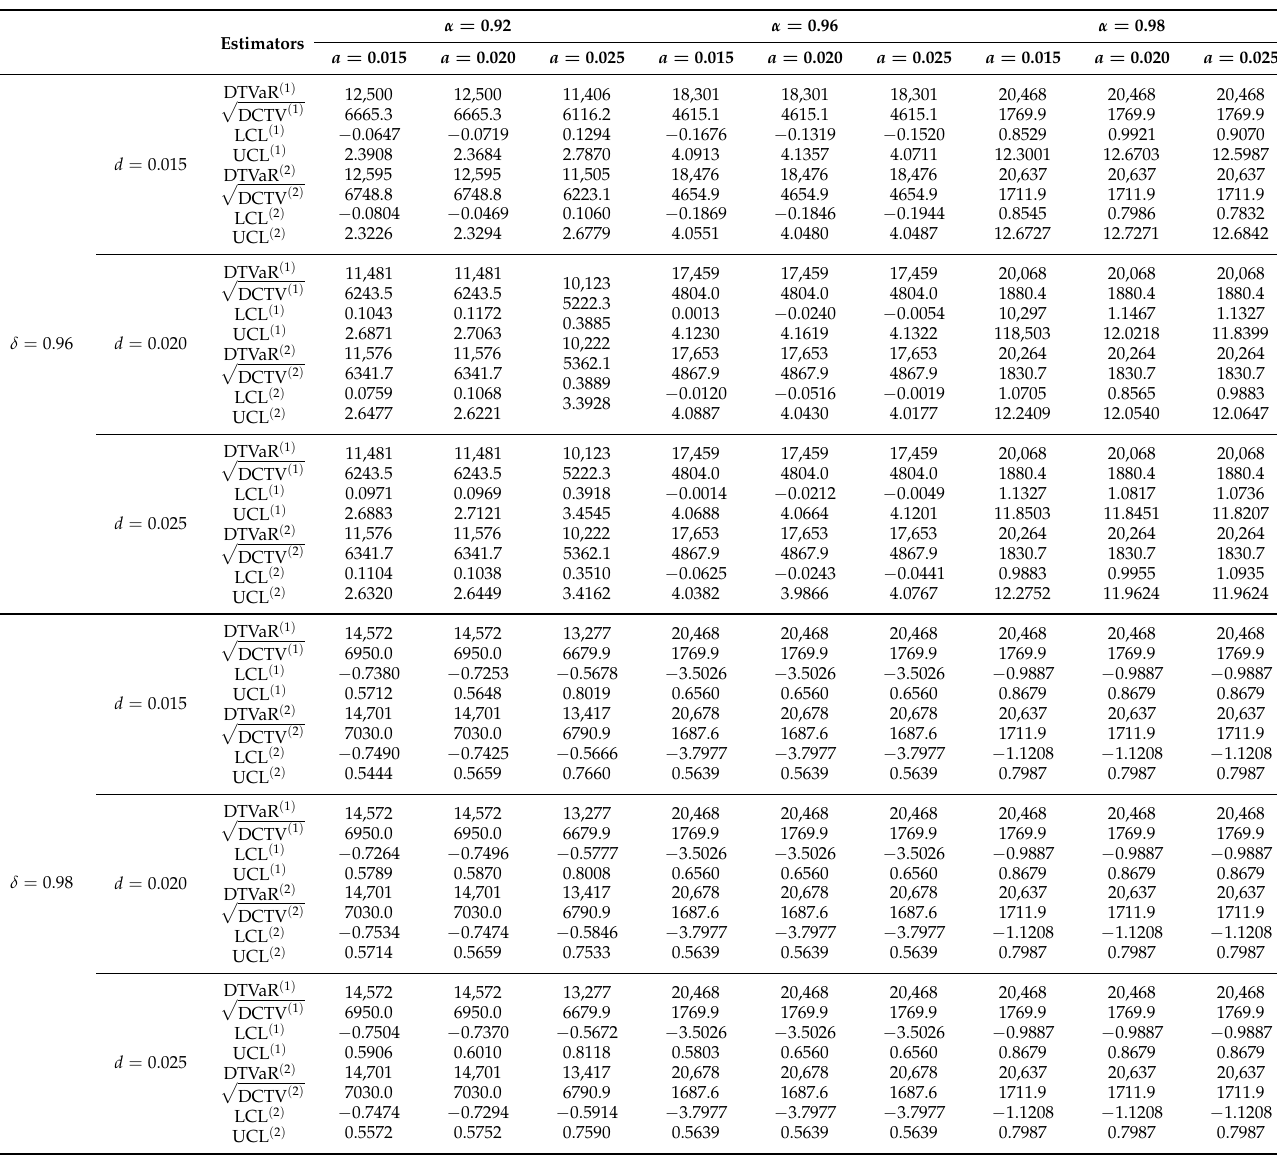
( δ , d ) ( X | Y ; C ) estimates and bootstrap confidence Table 5. DTVaR ( α , a )